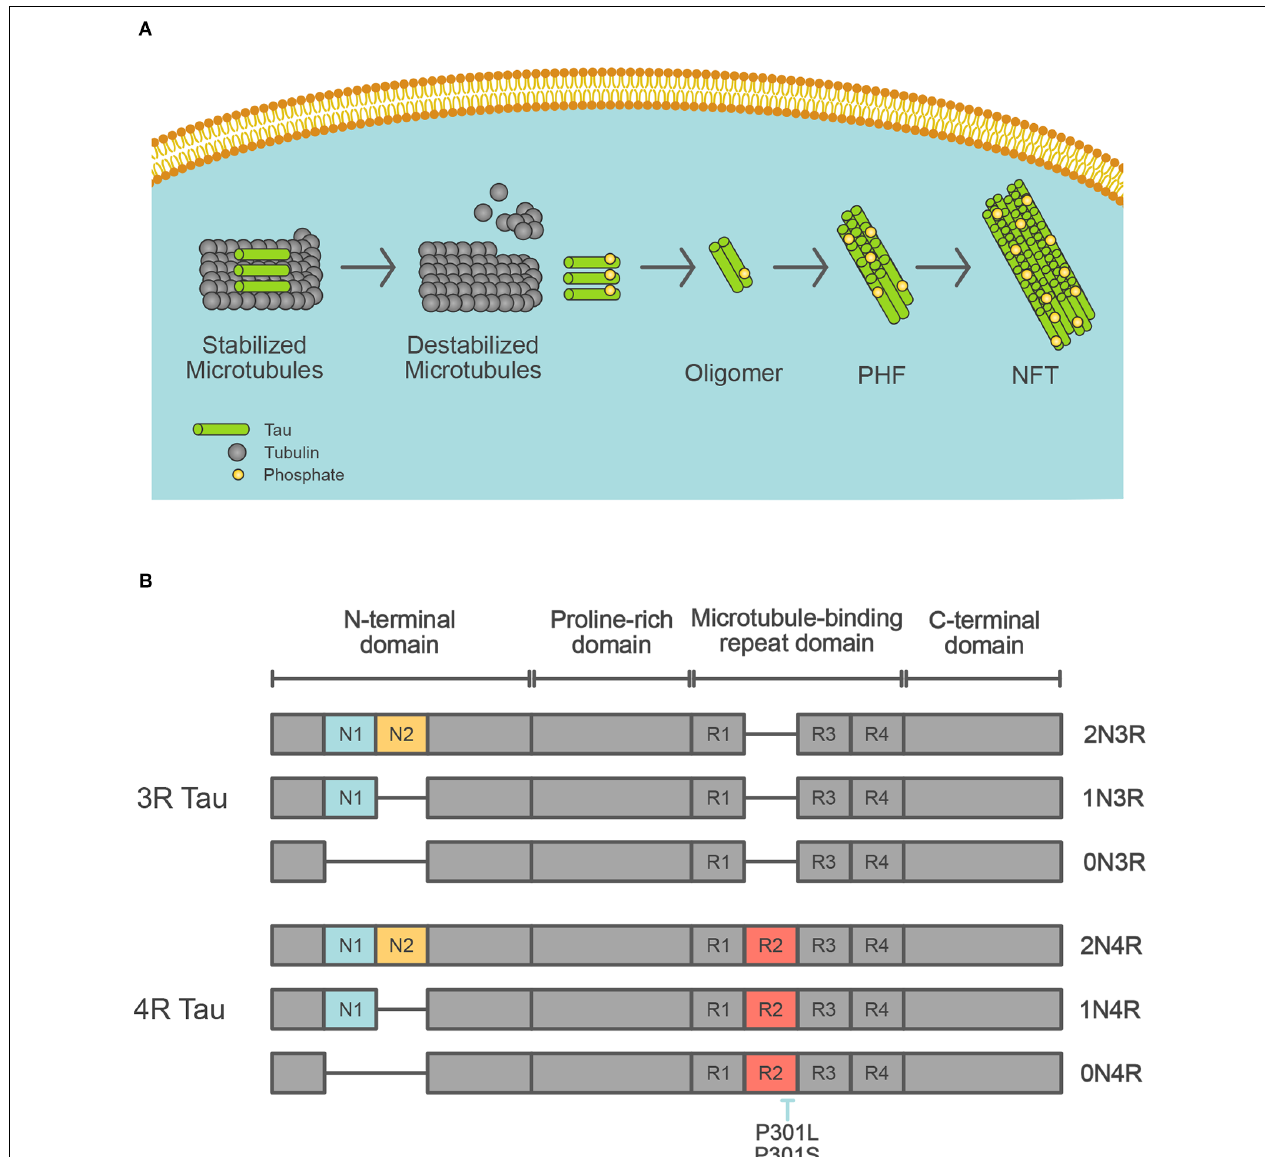
FIGURE 2 | Tau isoforms in the human brain. (A) Schematic depiction of the formation of neurofibrillary tangles. Tau protein control stabilization of microtubules by kinases. Phosphorylated tau leads to microtubule disassembly. Irregular hyperphosphorylation of tau proteins results in the generation of insoluble tau oligomers, which then accumulate to form PHF, then NFT. (B) Schematic diagram of tau isoforms that are expressed in the adult human brain. MAPT gene encodes tau protein. The six tau isoforms are generated by splicing of exons 2, 3, and/or 10 that encode for N1 (blue), N2 (yellow), and R2 (red), respectively. The inclusion of exon 10 results in the generation of mRNA encoding 4R tau. The location of missense MAPT mutations utilized in the transgenic mice is